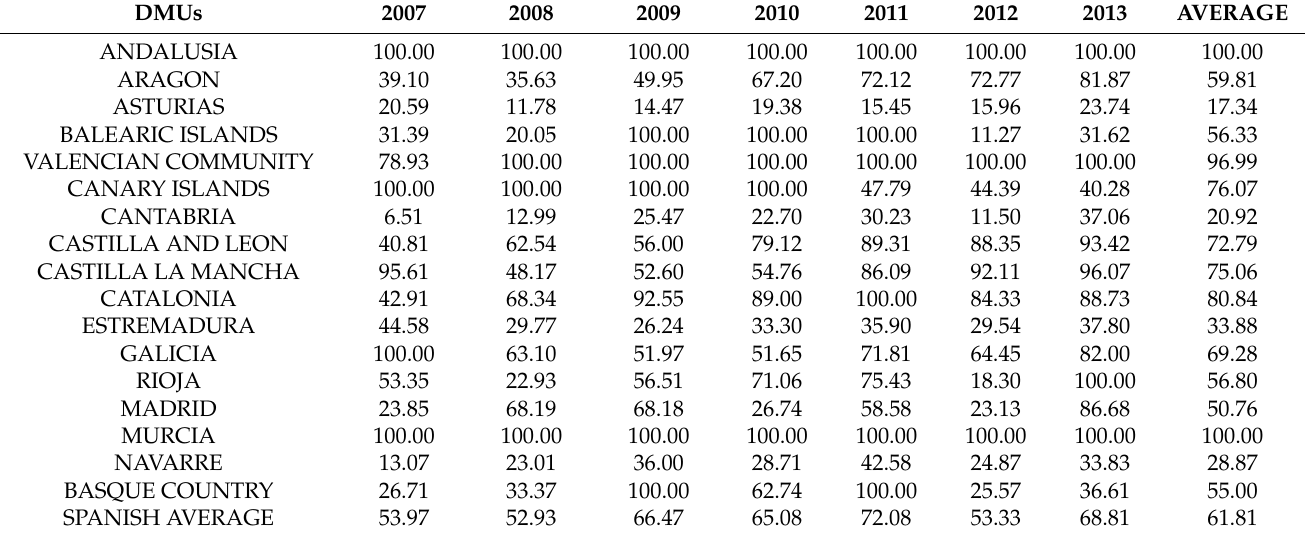
Table 5. Relative efficiency by regions for the period of 2007–2013 (Source: Own